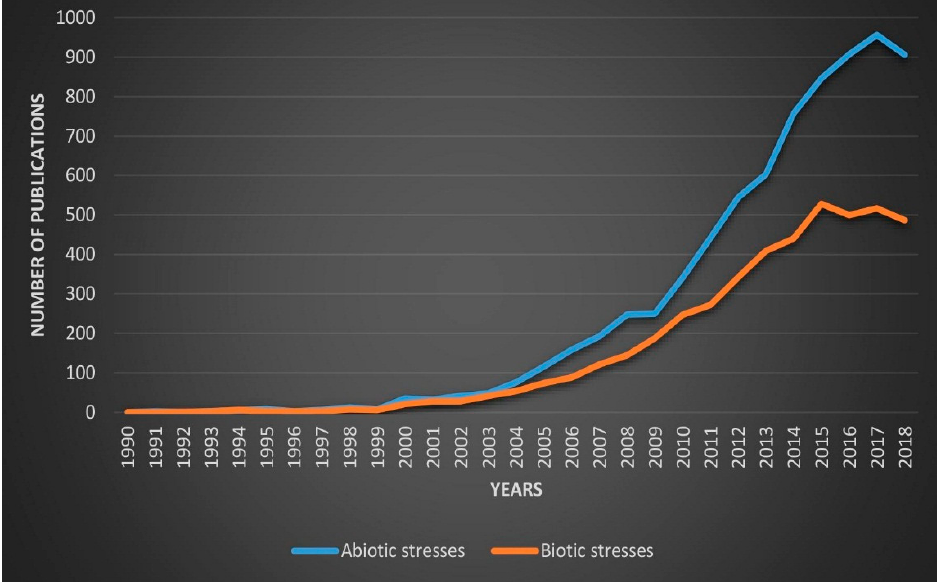
Figure 3. The number of publications per year related to abiotic and biotic stresses from Jan/1990–Nov/2018. Source: PubMed (Keywords (abiotic stresses, drought, cold, heat, salinity and water-logging), (biotic stresses, bacteria, virus, fungi, insects, parasites, and weeds) used to search the number of publications in PubMed).